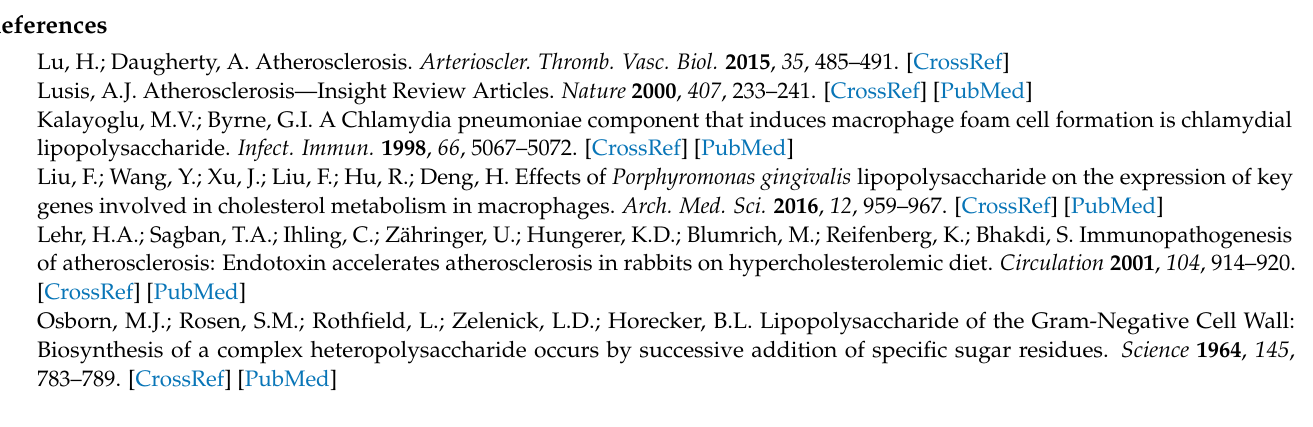
acid concentrations; Figure S7: 3OH-C:16 fatty acid concentrations; Figure S8: 3OH-C:18 fatty acid